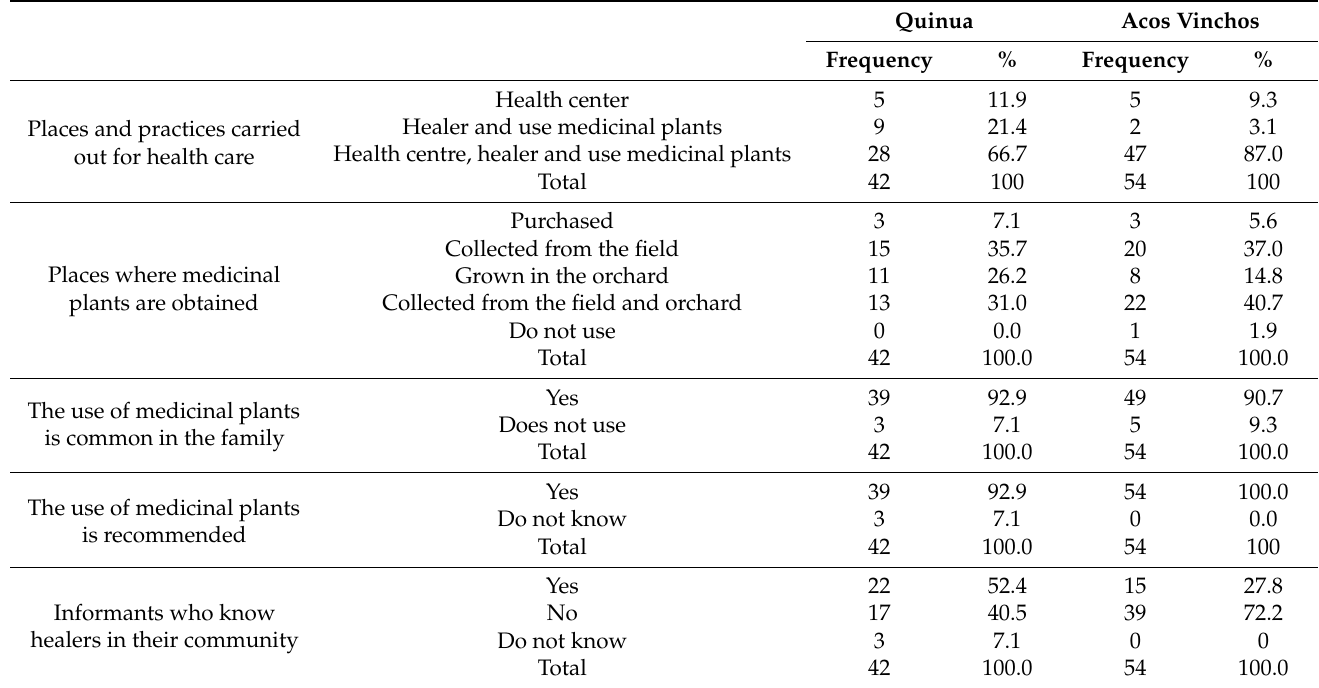
Table 6. Health care and use of medicinal plants in the districts of Quinua and Acos Vinchos.